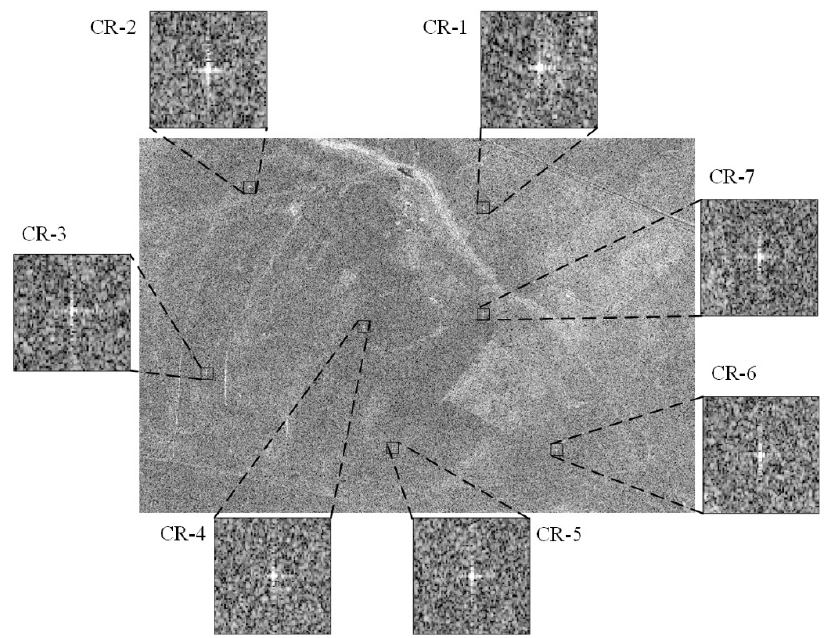
Figure 4. Distribution of automatic CRs of FSI mode images in the experimental area on 15 May.